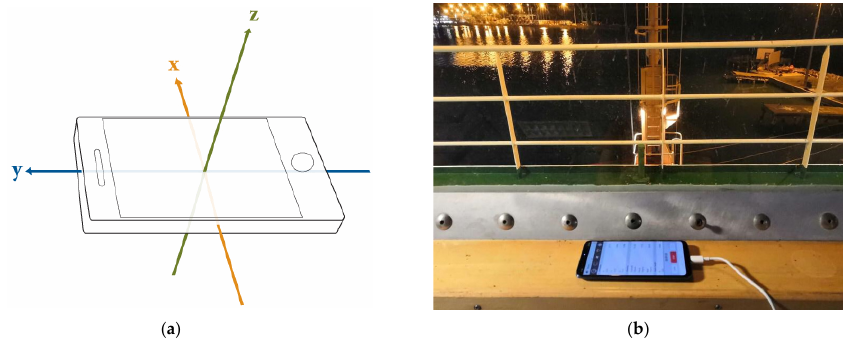
Figure 1. Coordinates and location of the device: ( a ) system coordinates of the device [19]; ( b ) installation of the device. In current research, the onboard measurements were performed by the smartphone “Xiaomi Mi 8”, located in the wheelhouse on the vertical line passing through the ship centre of mass. The selected location makes it possible to measure the heave acceleration amplitude, with no contribution due to the pitch motion that, in turn, increases among with the longitudinal distance from the vertical line passing though the ship centre of